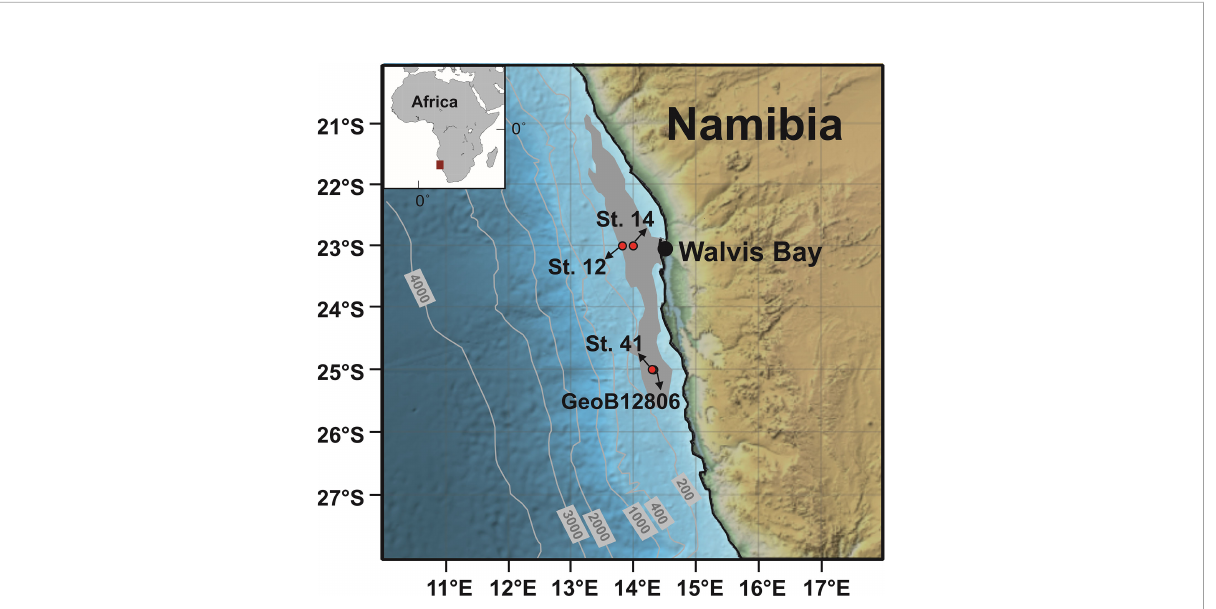
FIGURE 1 Sampling locations on the Namibian mud belt (bathymetry contours in m). The approximate extension of mud belt shown in gray is based on Inthorn et al. (2006) and Zabel et al. (2012) for surface sediments with total organic carbon (TOC) concentrations higher than 5 wt%. St. 12 (23° 00 ′ S; 13°52.0 ′ E; water depth = 151 m) is located at the edge of the mud belt. St. 14 (23°00 ′ S; 14°02.9 ′ E; water depth = 138 m), St. 41 (25°00 ′ S; 14°22.6 ′ E; water depth = 140 m), and GeoB12806 (25°00.4 ′ S; 14°23.5 ′ E; water depth = 133 m) are located inside the mud